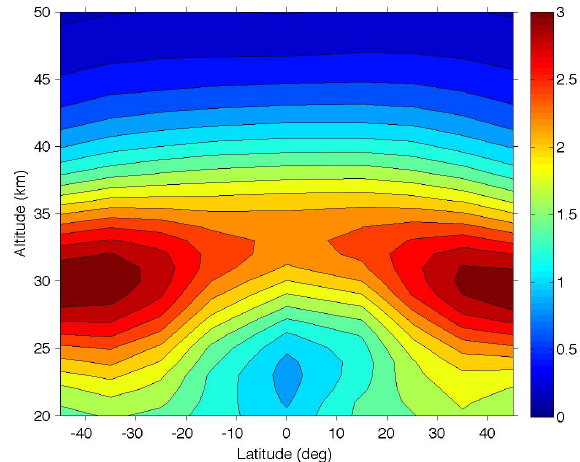
Fig. 19. The constant factor c(z) in the NO 2 time series as a func- tion of latitude and altitude. The scale is 10 9 cm − 3 .